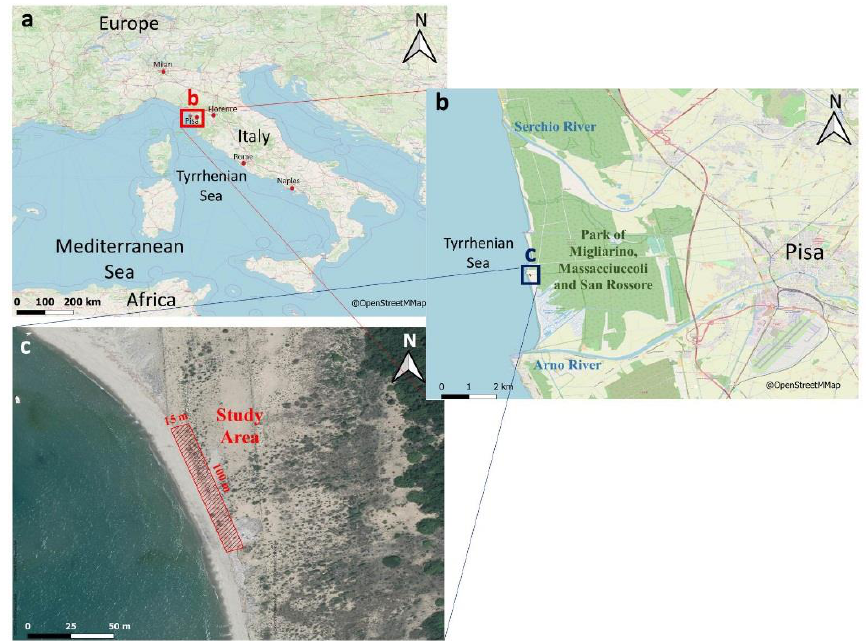
Figure1. Geographicallocationofthestretchofbeachstudied, ontheNorthernItaliancoast(coordinates: Figure 1. Geographical location of the stretch of beach studied, on the Northern Italian coast 10 ◦ 16’40.70” E 43 ◦ 42’55.07” N; 10 ◦ 16’42.12” E 43 ◦ 42’51.86” N; 43 ◦ 42’51.86” N; 10 ◦ 16’41.68” E (coordinates: 10°16 ’ 40.70 ” E 43°42 ’ 55.07 ” N; 10°16 ’ 42.12 ” E 43°42 ’ 51.86 ” N; 43°42 ’ 51.86 ” N; 43 ◦ 42’51.74” N; 10 ◦ 16’40.23”E 43 ◦ 42’54.93”N). Maps created by using QGIS 3.12 [48], 10°16 ’ 41.68 ” E 43°42 ’ 51.74 ” N; 10°16 ’ 40.23 ” E 43°42 ’ 54.93 ” N). Maps created by using QGIS 3.12 [48],